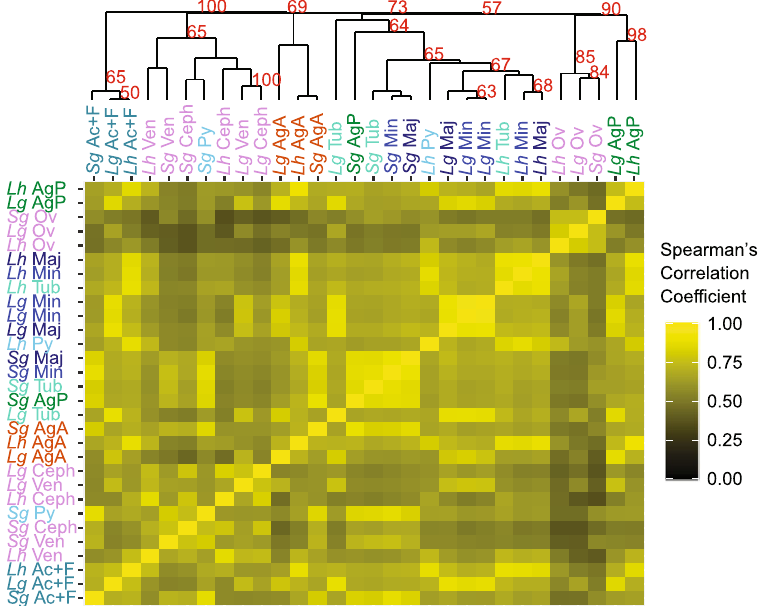
Figure 3. Correlation among multiple tissues for three spider species based on expression of 6550 ortholog groups. Heat maps show pairwise Spearman’s correlation coefficients based on the mean FPKM of orthologs identified with OrthoMCL. Correlation coefficients were used to hierarchically cluster the libraries (bootstrap proportions ≥ 50% shown). Silk gland and species abbreviations, and sample sizes, as in Fig. 1. Non-silk tissues are cephalothoraxes (Ceph), ovaries (Ov), and venom glands (Ven). There were two biological replicates for each non-silk tissue, except Lh Ven (n =